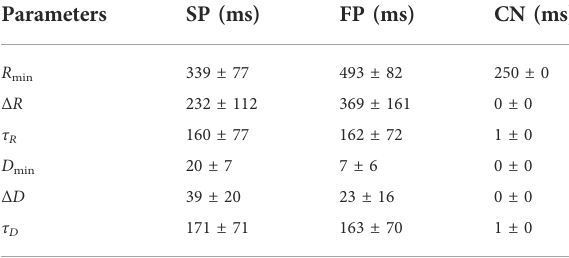
TABLE 2 Ranges of the 240 model parameters used for the illustration (mean ± std).